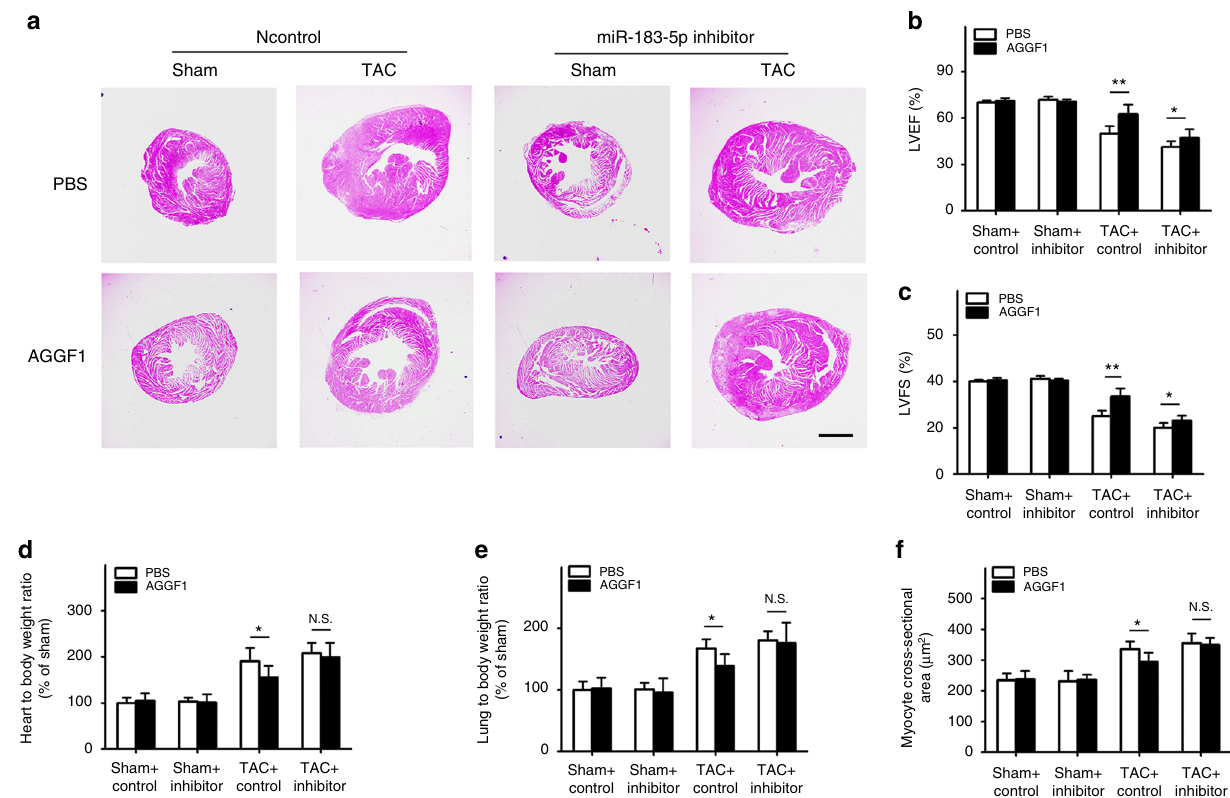
Fig. 8 Ago-miR-183-5p inhibitor blocks therapeutic effect of AGGF1. a H&E staining images of heart sections. Scale bar , 1mm. b LVEF. c LVFS. d Ratio of heart weight to body weight. e Ratio of lung weight to body weight. f Cross-sectional diameter ( µ m) of cardiomyocytes ( n = 10/group, * P < 0.05, ** P < 0.01, N.S. , Non- signi fi cant). Data are shown as the mean ± s.d. from at least three independent experiments. Statistical analysis was carried out by a Student ’ s two-tailed t